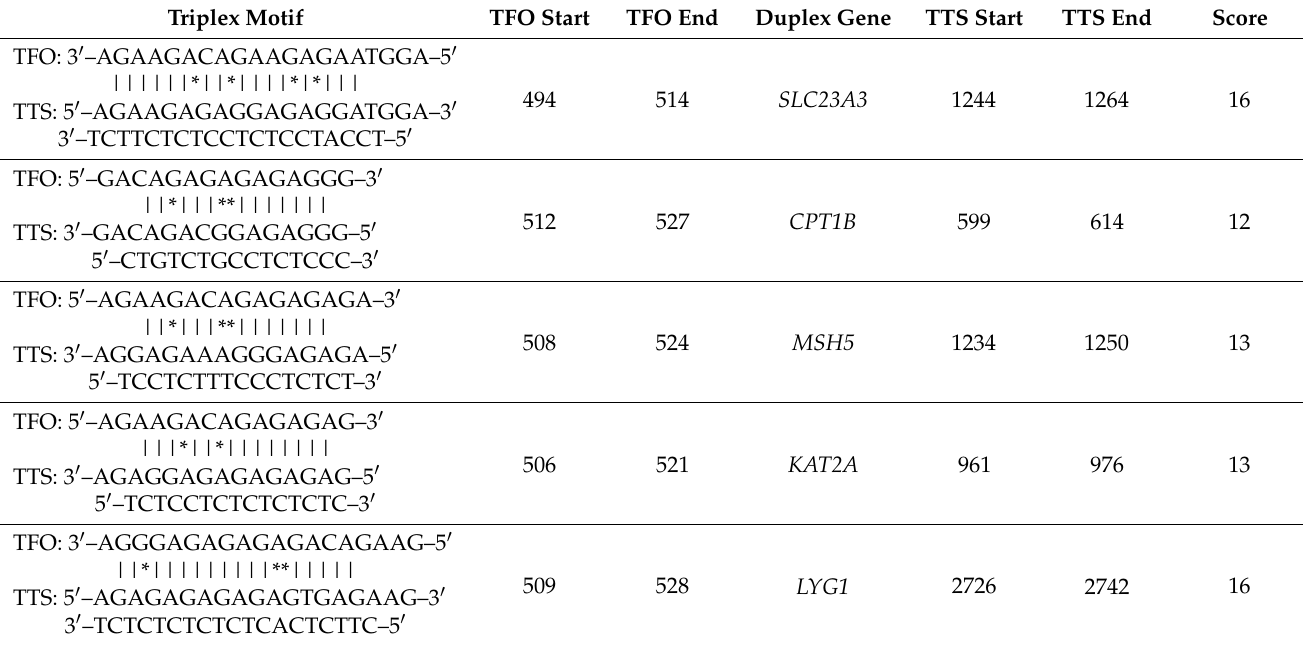
Table 5. Triplex motif of lncRNA–AD000684.2 (RNA TFO) with target genes (DNA duplex or